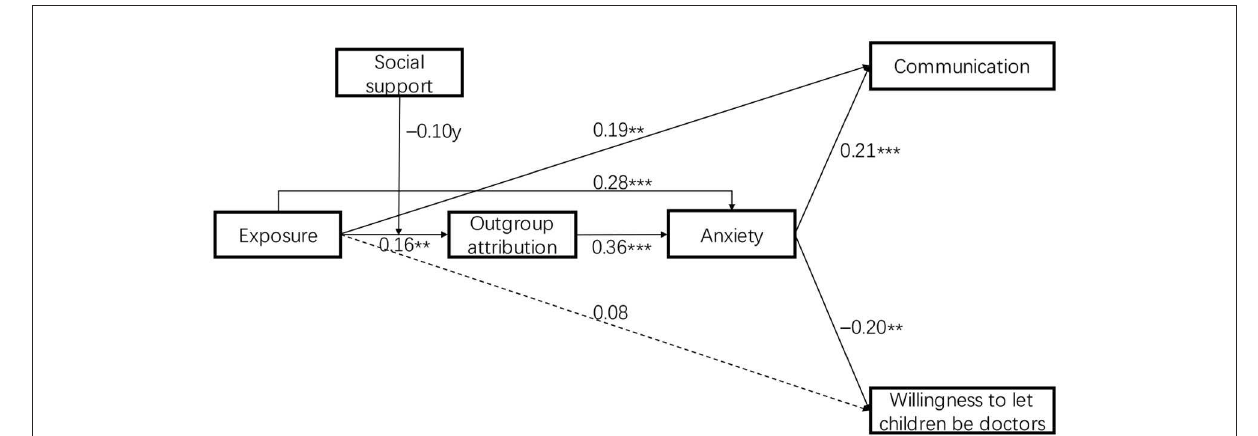
FIGURE2 Estimation of final moderated mediation model. † p < 0.1, ** p < 0.01, and *** p <